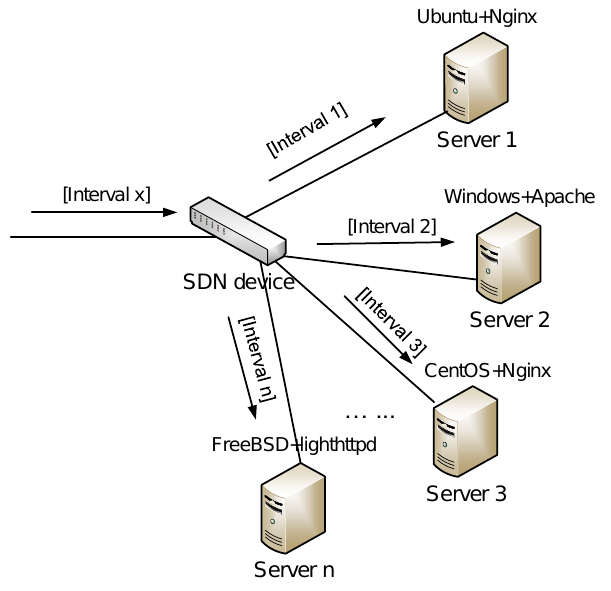
Figure 10. Moving Attack Surface with combined MTD strategies